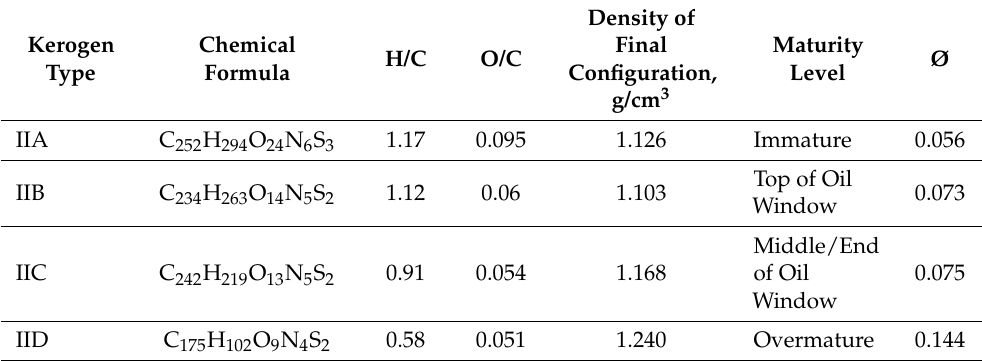
Table 2. Details of the kerogen units used in this investigation